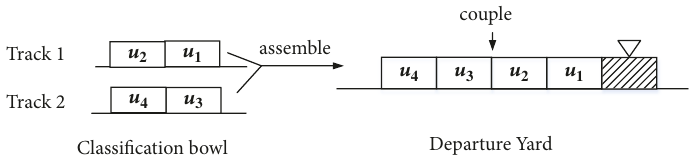
Figure 3: Coupling operation of the railcars from different tracks.